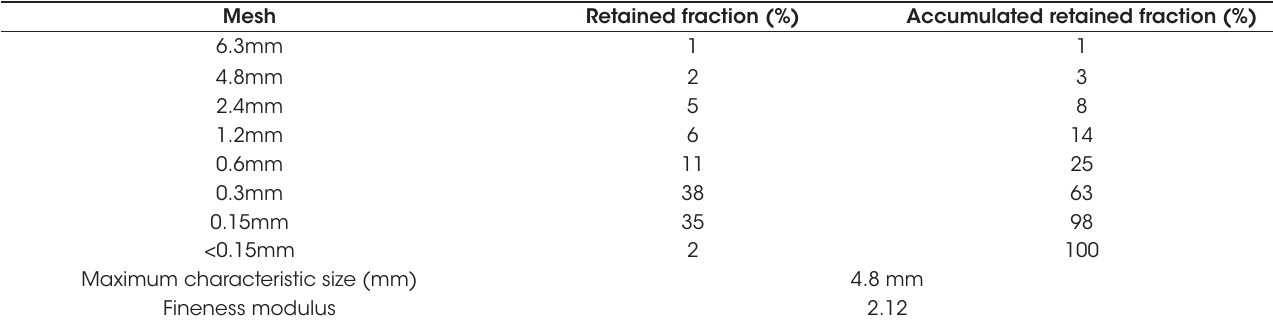
Grain size distribution of the natural fine aggregate used